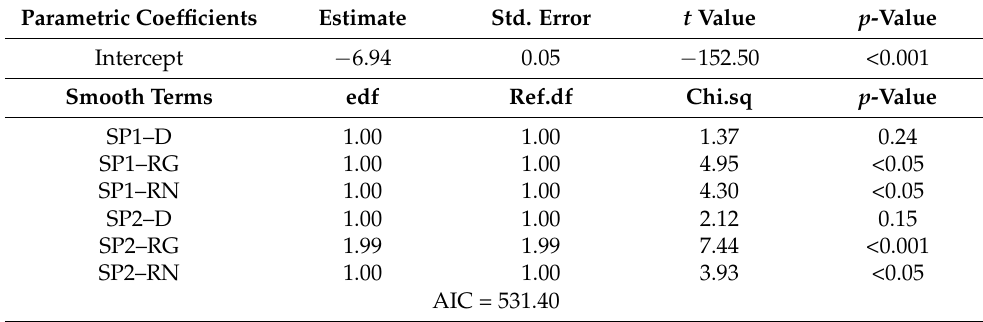
Table 4. Parameter estimates by the fixed effects of the generalized additive mixed model (GAMM) of daily increments in the last 15 days before capture in developing (D), regressing (RG) and regenerating (RN) European hake females captured in 2017. Parametric coefficients present: estimate, standard error (Std. error), z value, and p -value; smooth terms present: estimated degrees of freedom (edf), standard error (Std. error), z value, and p -value. Moreover, total Akaike Information Criterion (AIC) was